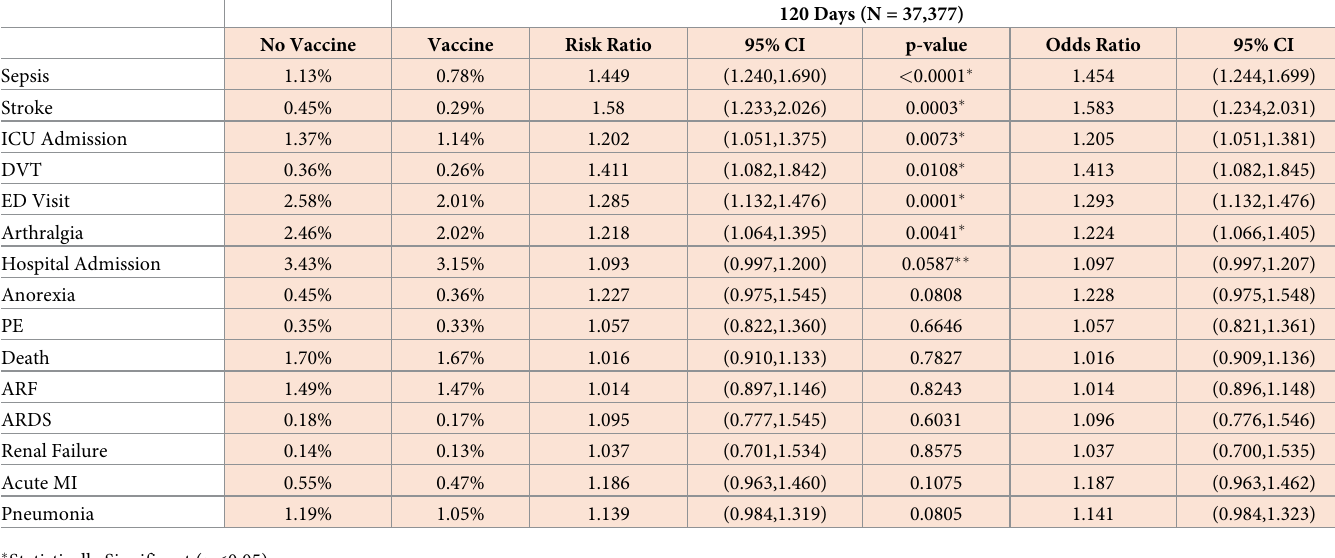
Table 5. Statistical analysis of adverse outcomes within 120 days of SARS-CoV-2-positive diagnosis.